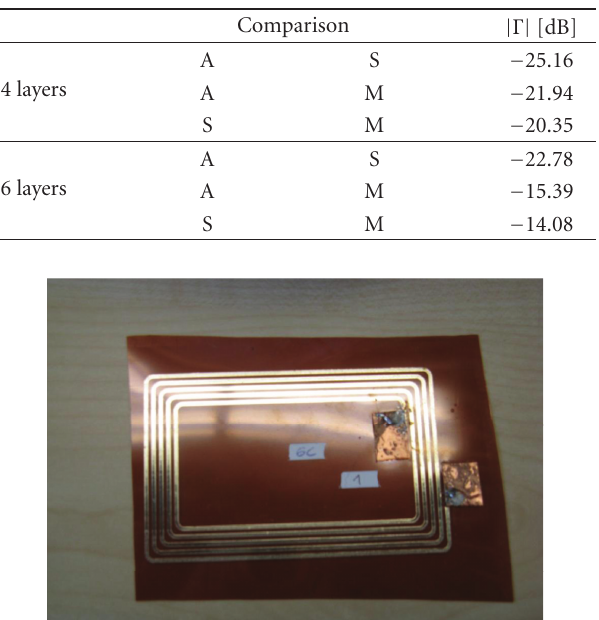
Table 4: Results validation.